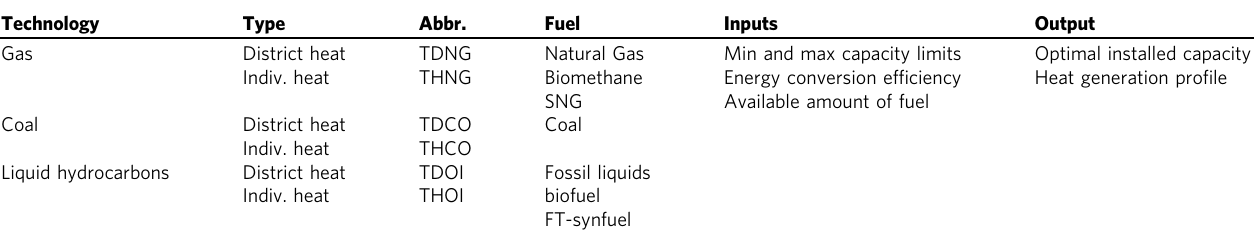
Table 7 Fossil-based heat generation